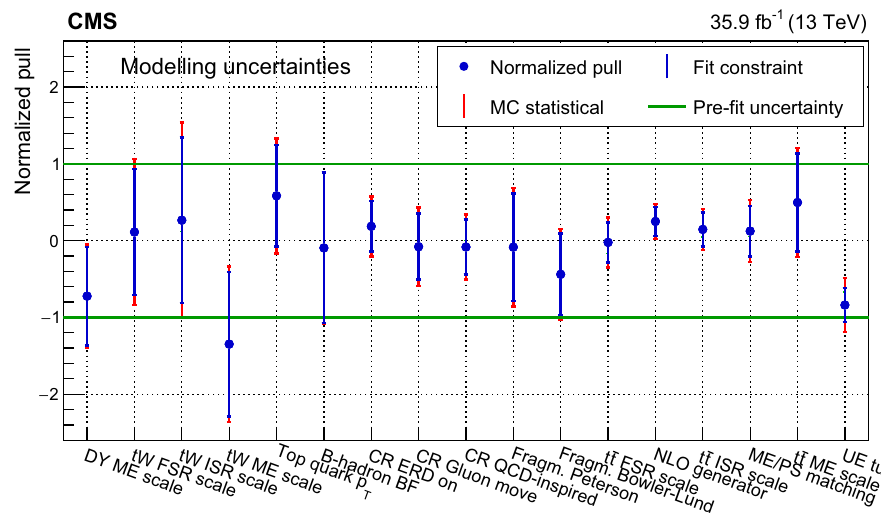
Fig. 10 Normalized pulls and constraints of the nuisance parameters related to the modelling uncertainties for the simultaneous fit of σ tt and m MC t . The markers denote the fitted value, while the inner vertical bars represent the constraint and the outer vertical bars denote the additional uncertainty as determined from pseudo-experiments. The constraint is